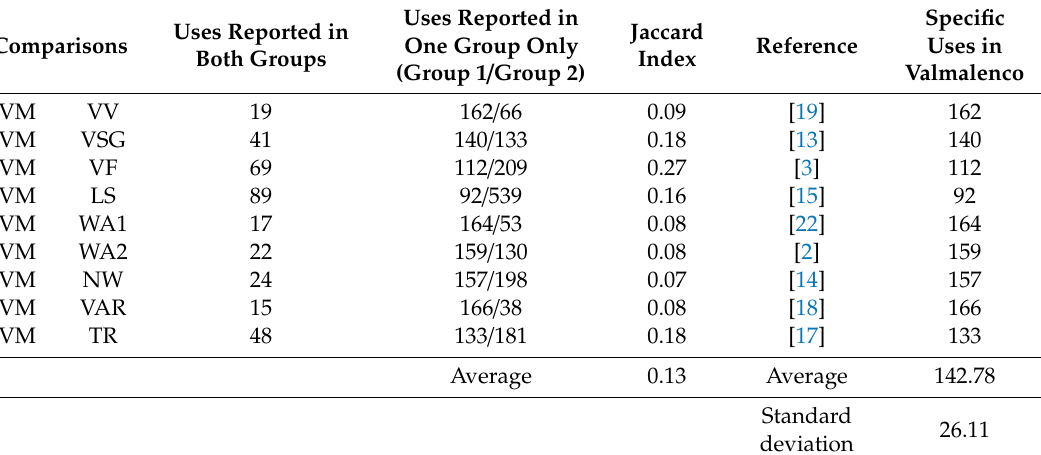
Table 3. Comparison among ethnobotanical works in Alpine and Prealpine regions. Jaccard Similarity Index of medicinal plant uses (veterinary excluded) in Valmalenco (VM) and in neighboring areas.